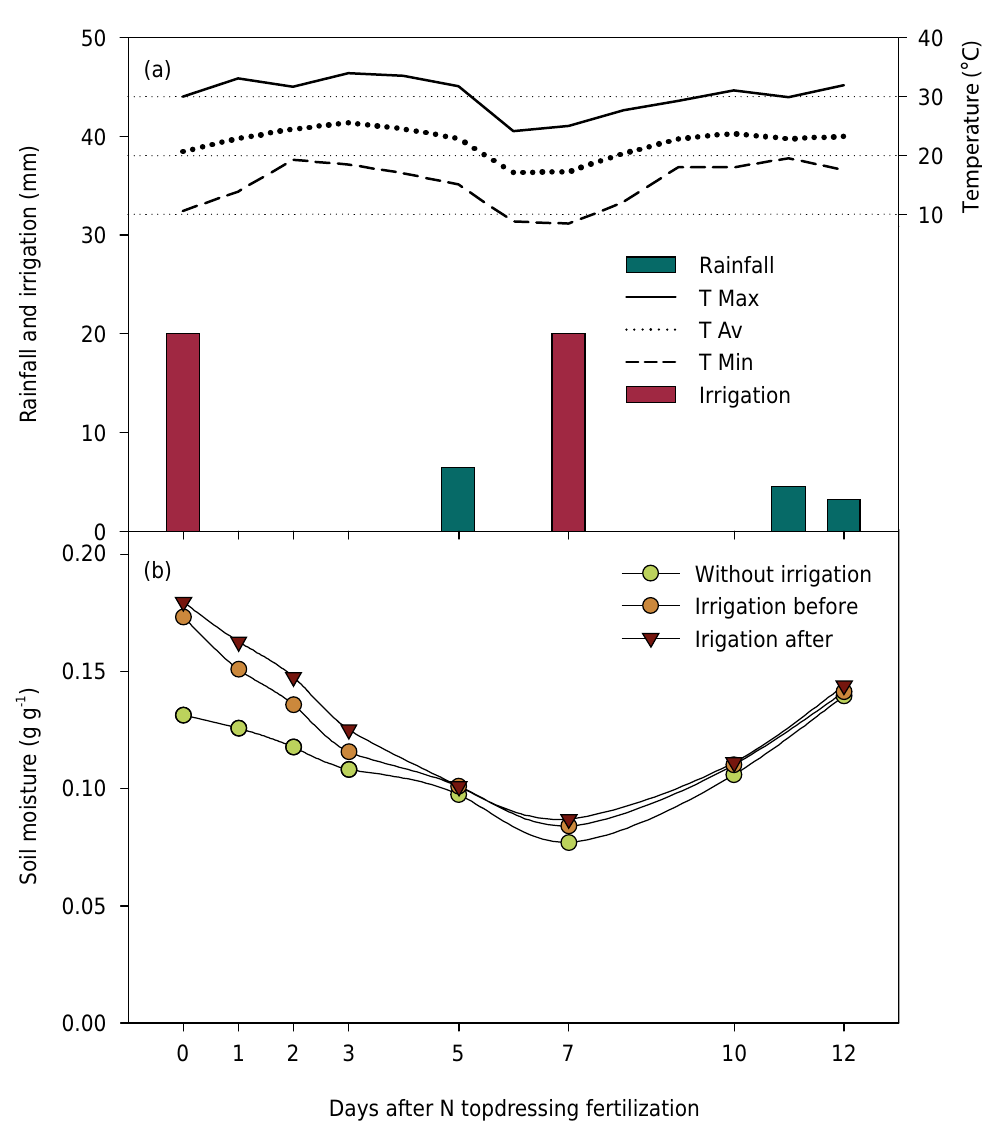
Figure 3. Rainfall, irrigation and daily air temperature [maximum (T Max), average (T Av) and minimum (T Min)] (a); and soil moisture (b) over a period of 12 days (sampling) following N application under three different irrigation